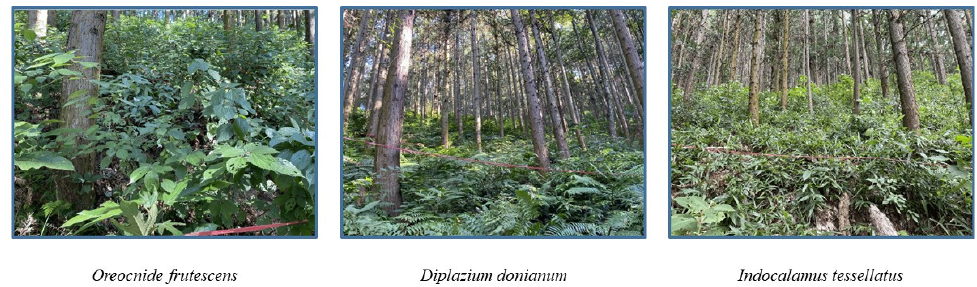
Figure 1. Three undergrowth dominant planting communities.